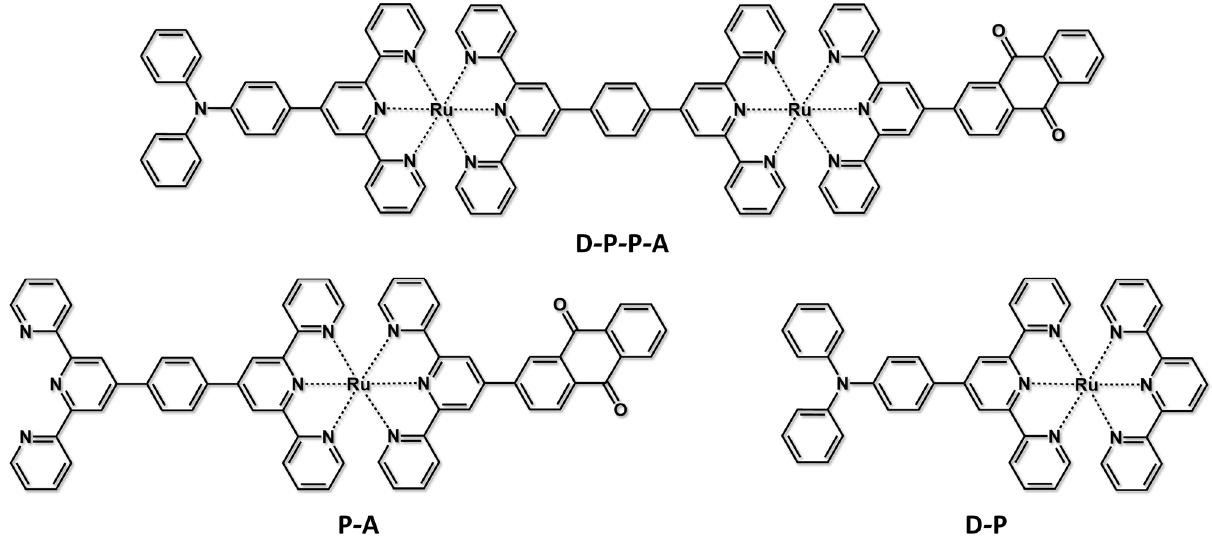
Figure 8. Structural formulae of D-P-P-A species and its model compounds P-A and D-P.